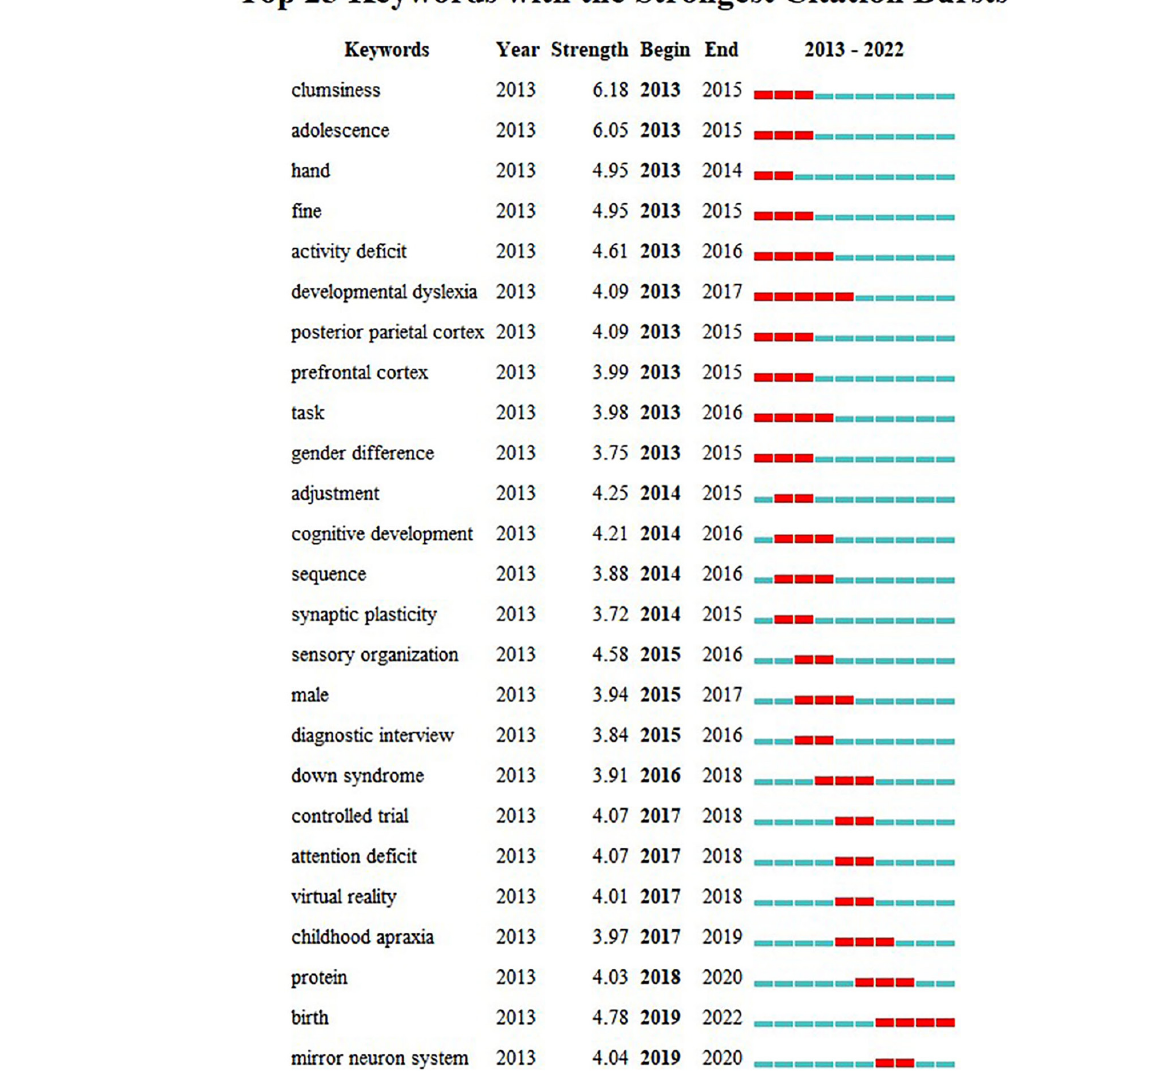
FIGURE6 Burst detection of keyword analysis. Each year from 2013 to 2022 is set as a time zone division, with the blue line in the diagram indicating the time interval and the red line indicating the time period when the keyword burst is